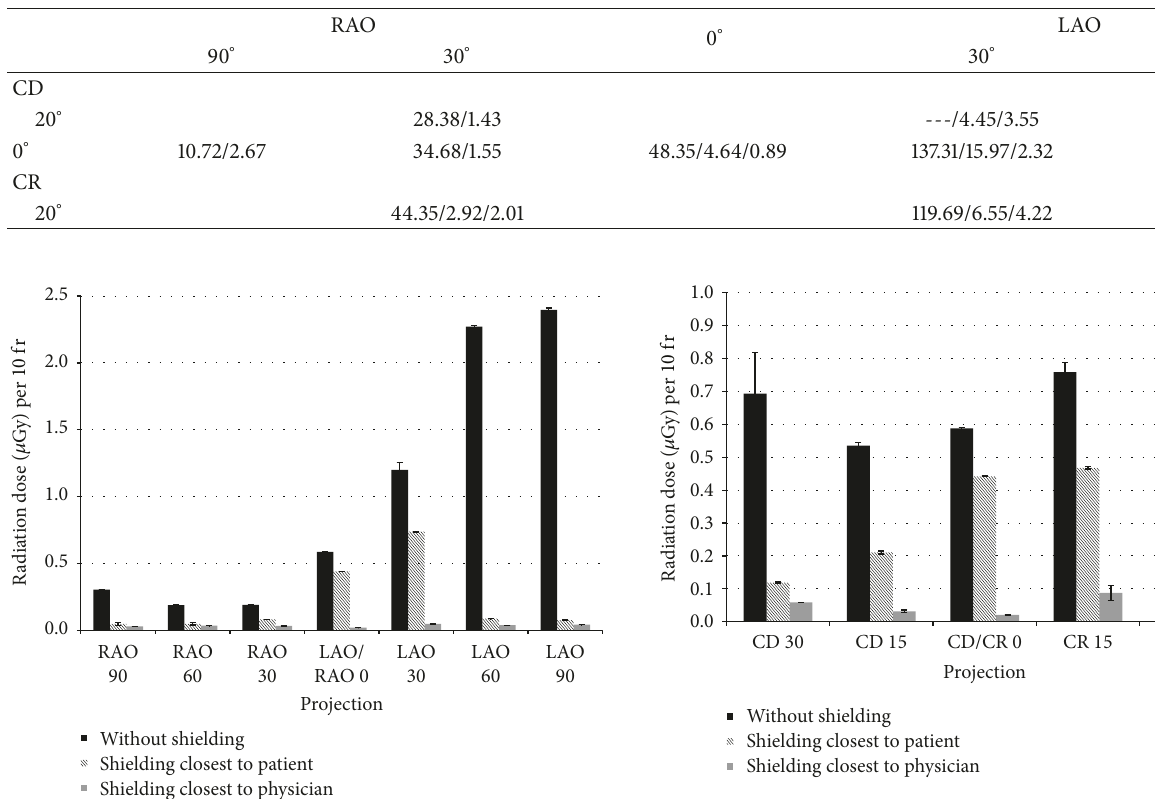
Table 2: Doses ( 𝜇 Gy) from scatter radiation per 10 fr in radiology for different projections (in each cell, dose without the use of shielding, with shielding placed close to the patient, and with shielding placed close to the physician. Hyphens mean that the values could not be measured because the dose rate was too high. When there are only two values in the cell, the measurements with shielding placed close to the patient and with shielding placed close to the physician were the same. All the values differ significantly at 0.05.).